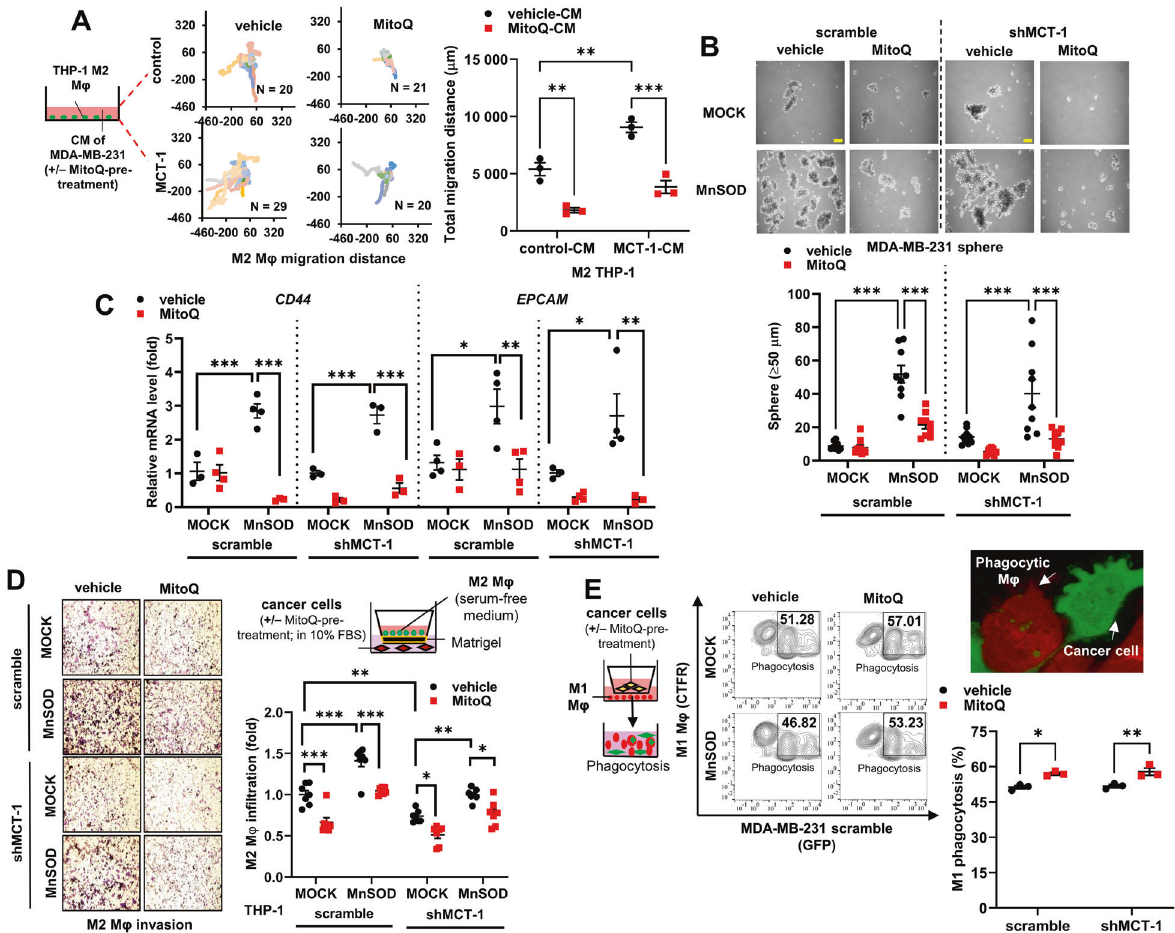
Fig. 5 MitoQ inhibits TNBC stemness, M2 macrophage invasion, and M1 macrophage phagocyticity. A Quanti fi cation of the total migration distance (right) of M2 THP-1 macrophages after culture in CM from MDA-MB-231 cells (control, MCT-1) with or without MitoQ (mROS quencher) pretreatment (right). Macrophage trajectories (left) emanating from the origin were plotted using the DiPer program. B Without (vehicle) or with MitoQ treatment, mammosphere formation ( ≥ 50 µm in diameter) by MDA-MB-231 cells (scramble vs. shMCT-1) with or without MnSOD induction (MOCK vs. MnSOD) was quanti fi ed. Scale bar, 50 µm. C CD44 and EPCAM mRNA levels were examined in MDA-MB-231 mammospheres (day 14) (scramble vs. shMCT-1) with or without MnSOD overexpression (MOCK vs. MnSOD) and without